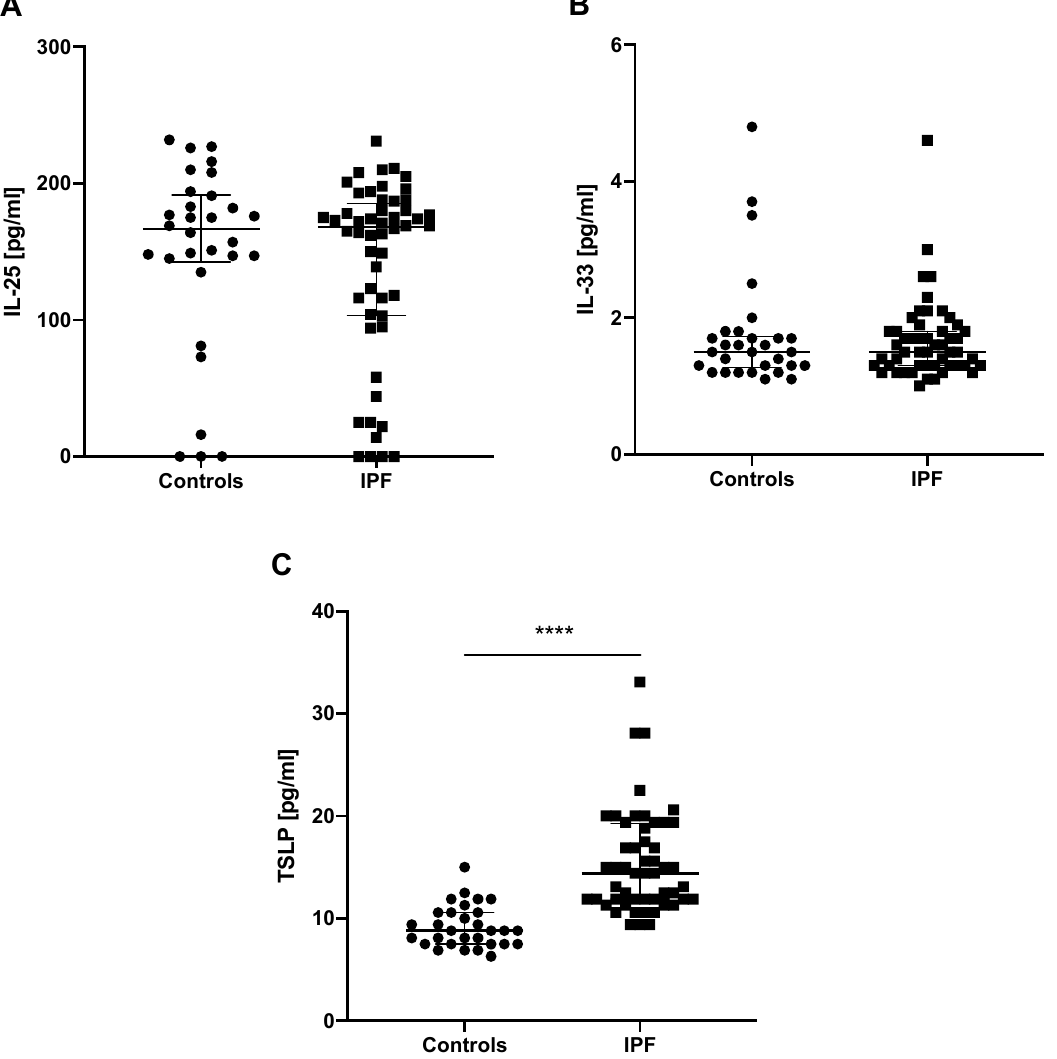
Figure 2. Baseline epithelial alarmin levels in the EBC of controls and patients with IPF. Notes: Panels showing: ( A ) baseline IL-25 EBC levels; ( B ) baseline IL-33 EBC levels; ( C ) baseline TSLP EBC levels; **** p < 0.0001. EBC—exhaled breath condensate, IPF—idiopathic pulmonary fibrosis, IL-25—interleukin 25, IL-33—interleukin 33, TSLP—thymic stromal lymphopoietin.